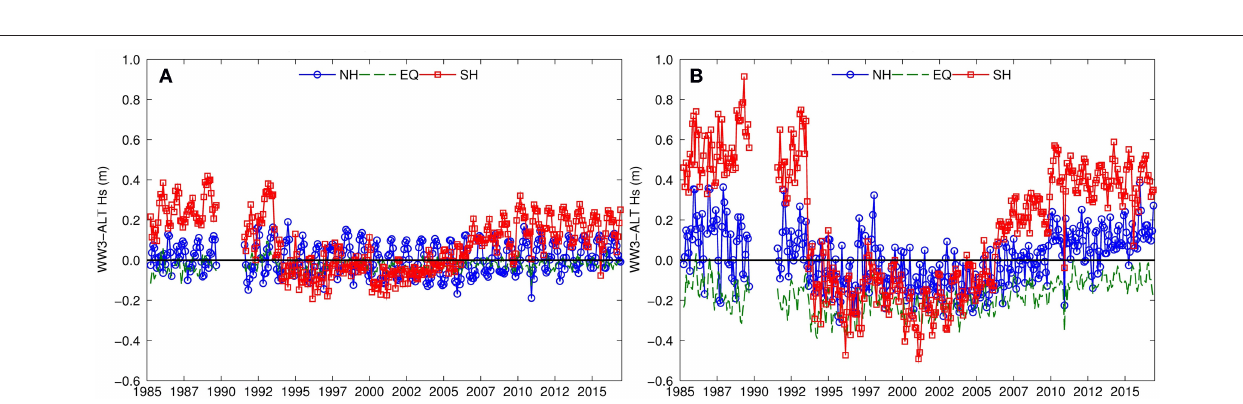
FIGURE 5 | (A,B) show H s monthly median (50th percentile P50) and P95 residuals: wave hindcast forced by CFSR - altimeter. The statistics are computed for latitudinal bands: Northern Hemisphere (NH: latitude > 30 ◦ N), Equator (EQ: latitude < 30 ◦ ), and Southern Hemipshere (SH: latitude > 30 ◦